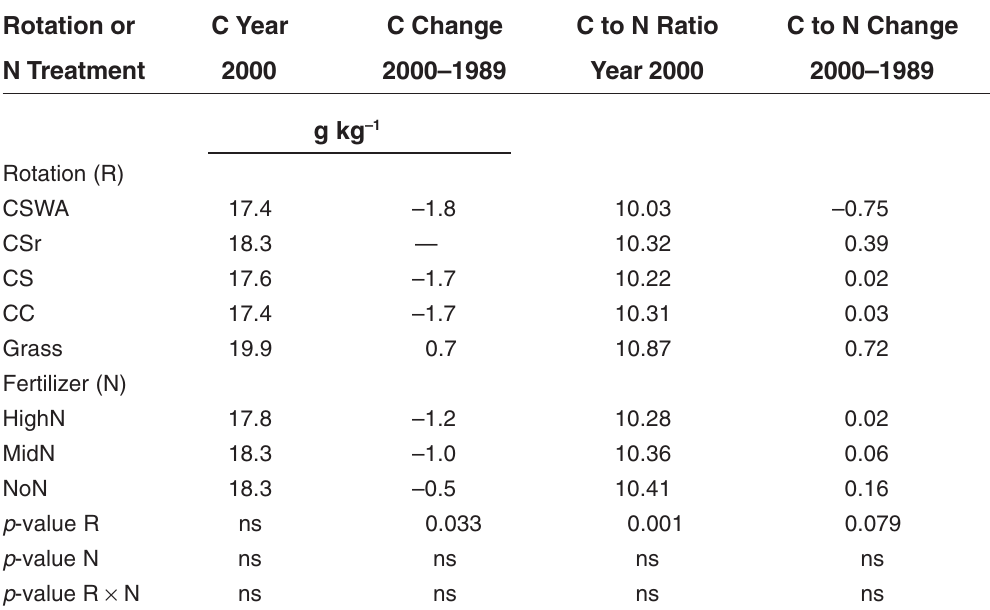
Total Soil C, Change in Soil C (2000–1989), Ratio of Total C to total N, and Change in C to N Ratio (2000–1989) in the Top 15